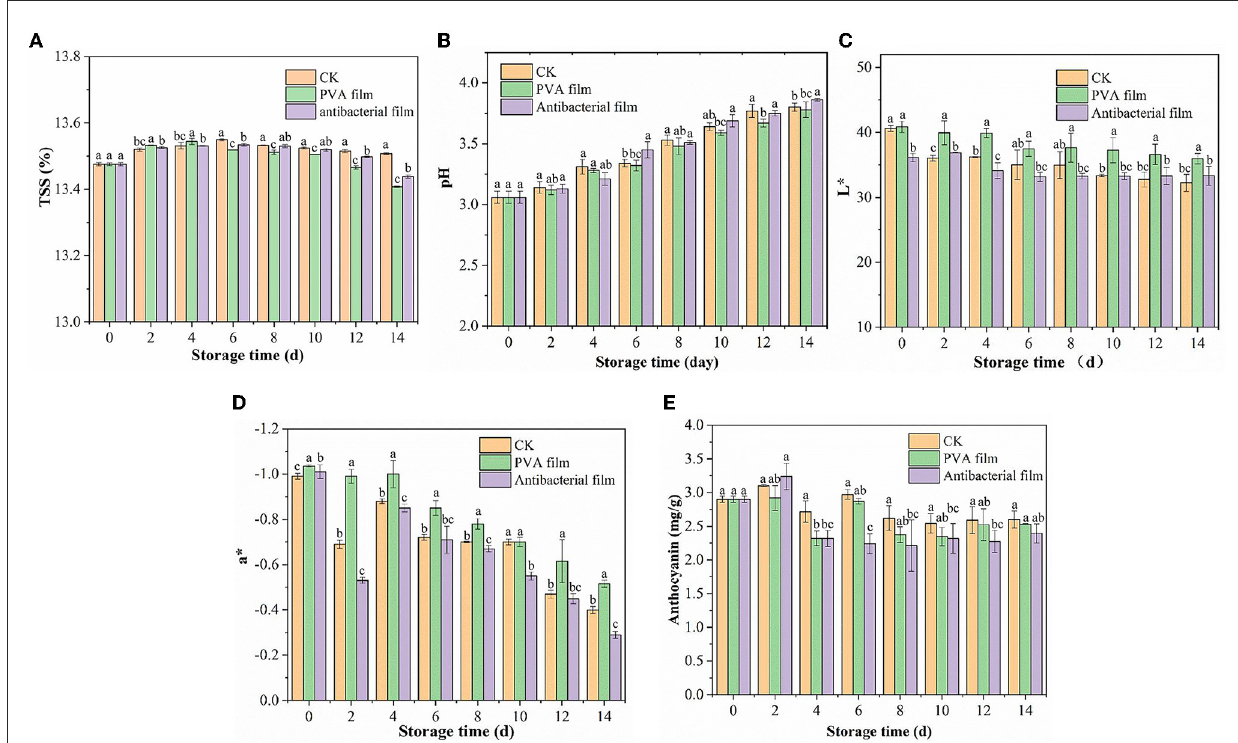
FIGURE5 Changes in soluble solids of each group of blueberries during storage (A) . The results of pH changes of blueberries in each group during storage (B) Changes of L* (C) and a* (D) values of blueberries in each group during the storage period. Changes in anthocyanin content of blueberries in each group during storage (E)